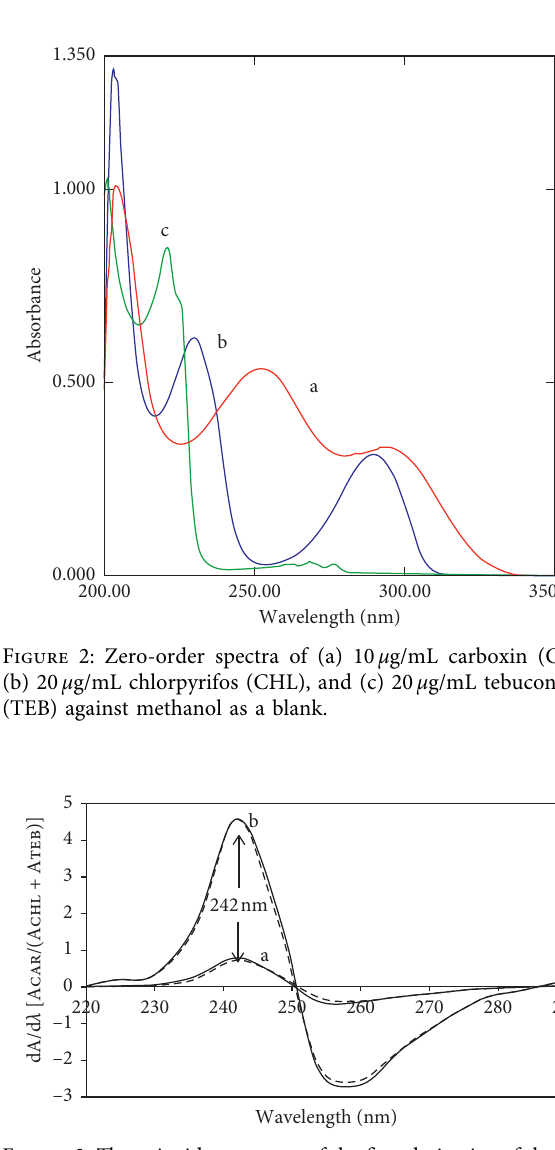
Figure 3: The coincident spectra of the first derivative of the ratio spectra of (a) 5 μ g/mL pure CAR ( ___ ) and 5 μ g/mL CAR in a ternary mixture (-----), and (b) 30 μ g/mL pure CAR ( ___ ) and 30 μ g/ mL CAR in a ternary mixture (-----) in methanol using 10 μ g/mL CHL +10 μ g/mL TEB as a double divisor at Δ λ � 6.